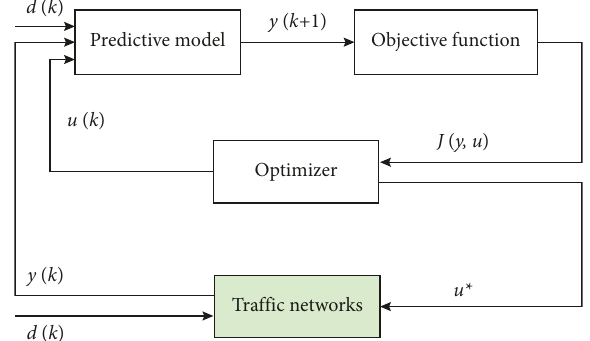
Figure 1: Schematic diagram of MPC for TSC.